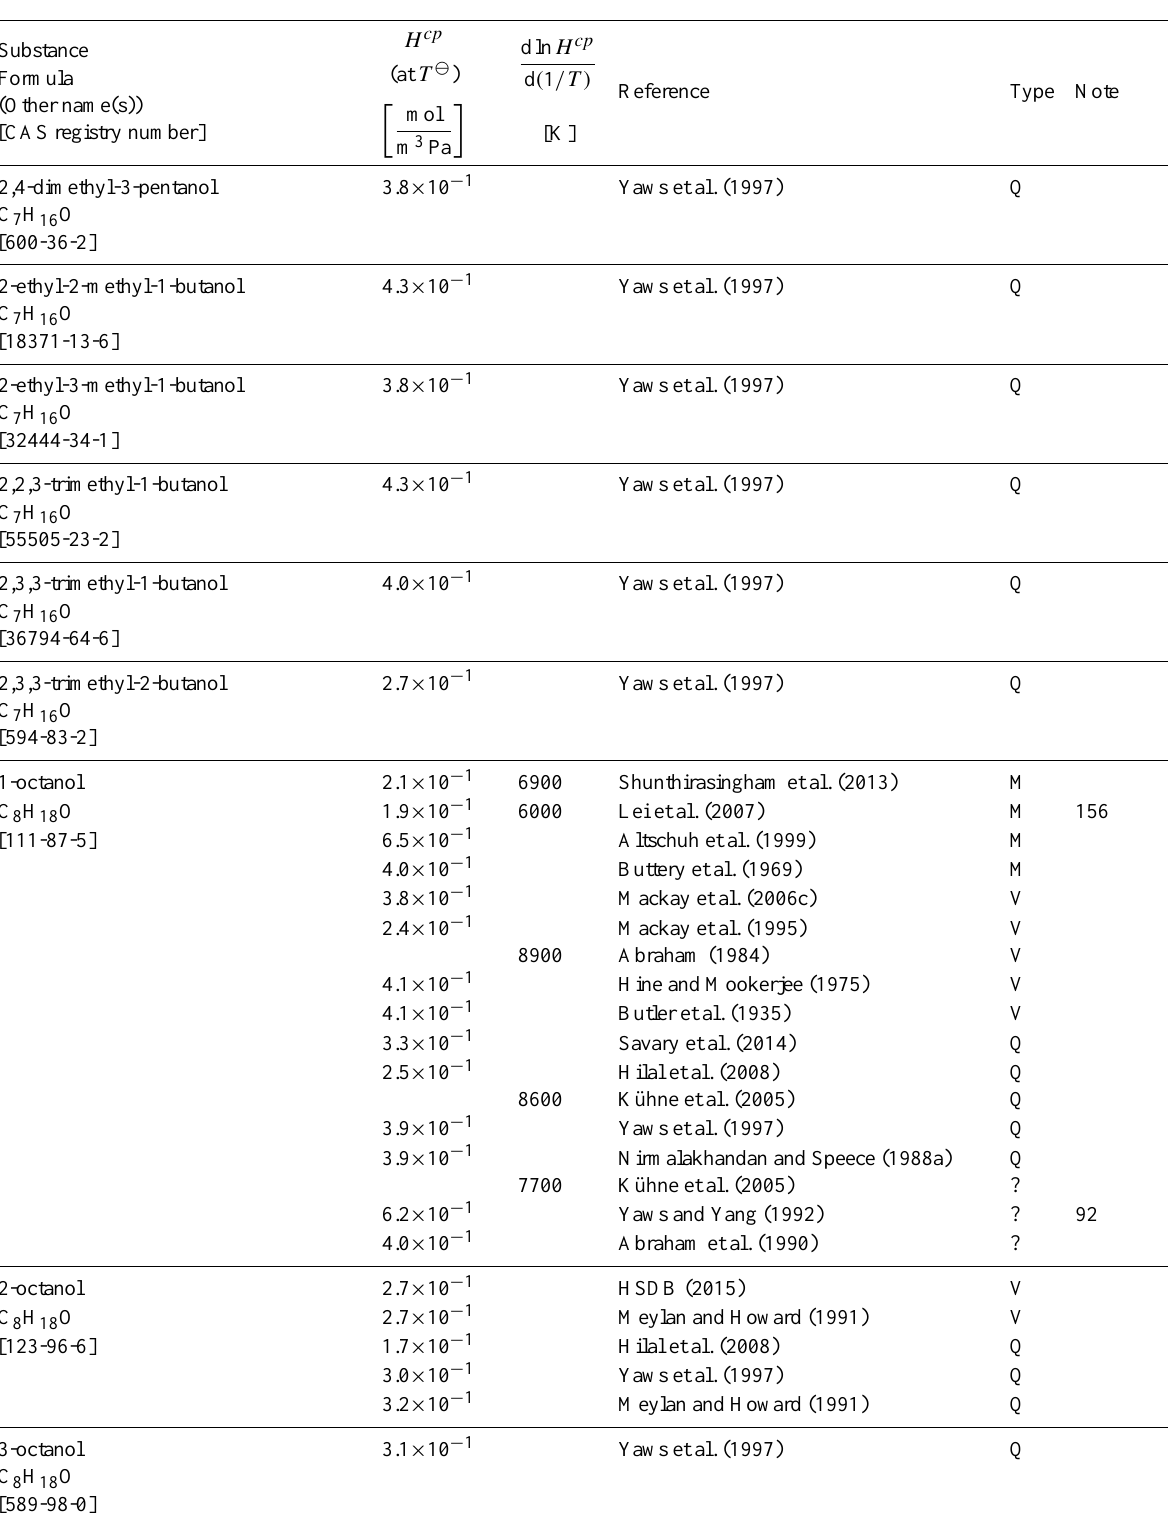
Table 6: Henry’s law constants for water as solvent